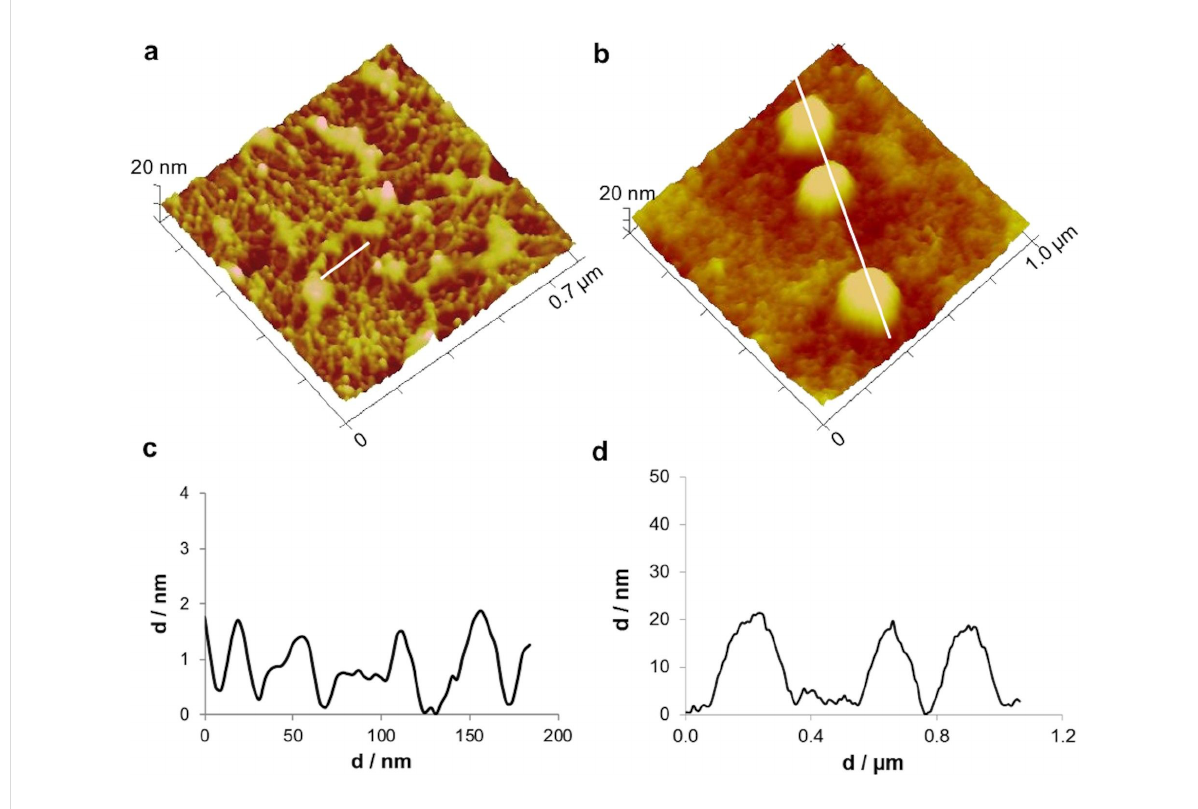
Figure 4: Peak force tapping AFM (PFT-AFM) 3D height images and profiles of small-sized areas of the moist adhesive material deposited by the tube feet of Paracentrotus lividus on mica. a) Height image and c) profile of the threads of aggregated globular nanostructures in a thinner peripheral area of the adhesive material. b) Height image and d) profile of the larger, globular structures in a thicker central area of the adhesive material. Images were obtained with a ScanAsyst-Air